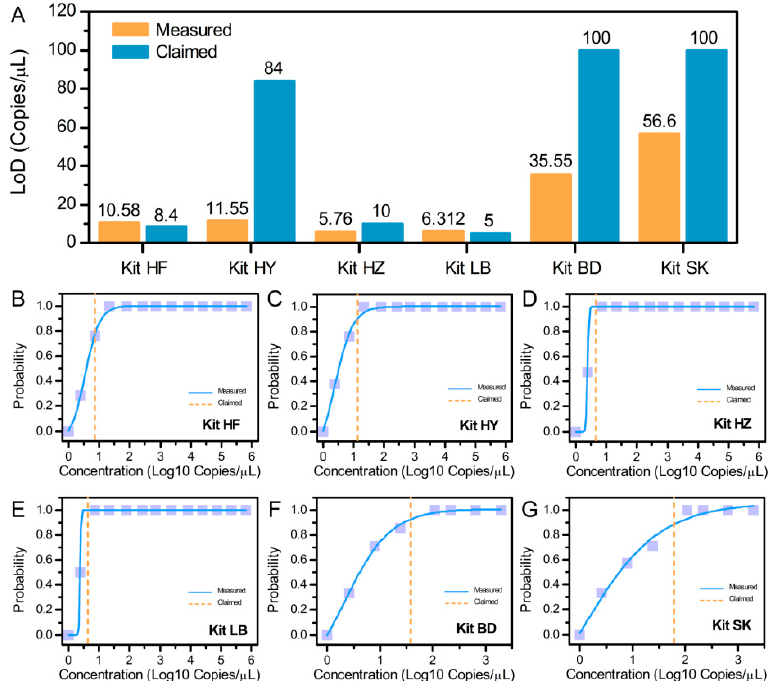
Figure 4. Evaluation of LODs of commercial assays. ( A ) Comparison of LODs claimed by the kit manufacturer using six duck DNA detection kits with the LODs determined with the CRMs. ( B – G ) Probit regression analysis of the six assays for the detection of duck IL2 (SPSS 16.0). The probit versus IL2 concentration (( B – E ) mitochondrial gene, ( F , G ) nuclear gene) was obtained from 21 replicates of serial dilutions and an additional 10 replicates of a blank sample.